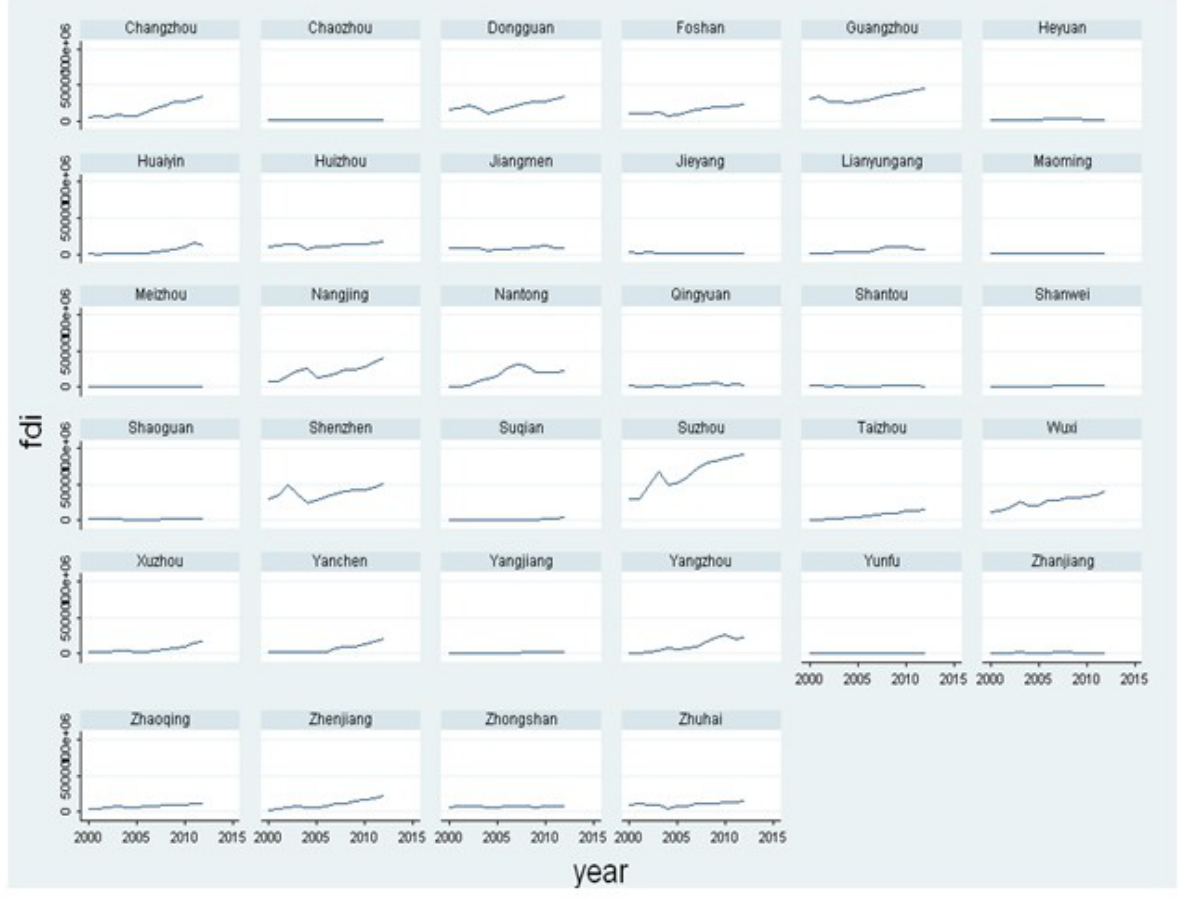
Figure 2. FDI trends change